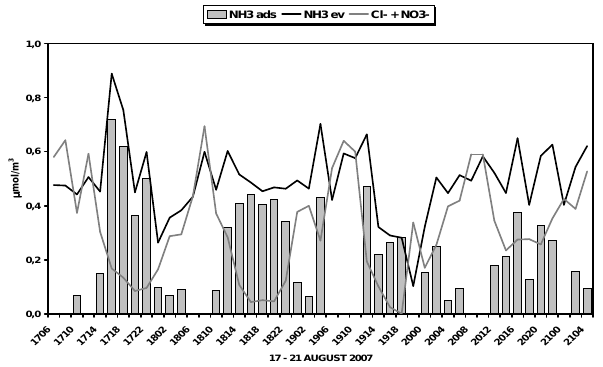
Fig. 10. Comparison between the amounts of evaporated ammo- nia (NH 3ev ) and of its anions (Cl − +NO − and trend of unbalanced ammonia (NH 3adsonparticulate ) during the intensive summer measurements at PKU